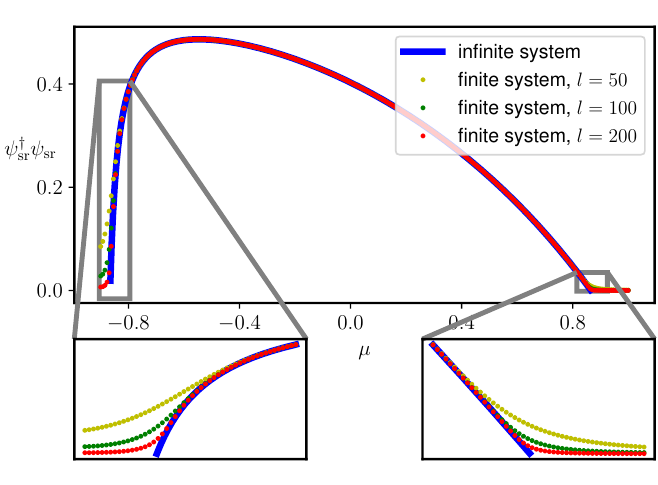
ψ as a function of sr sr